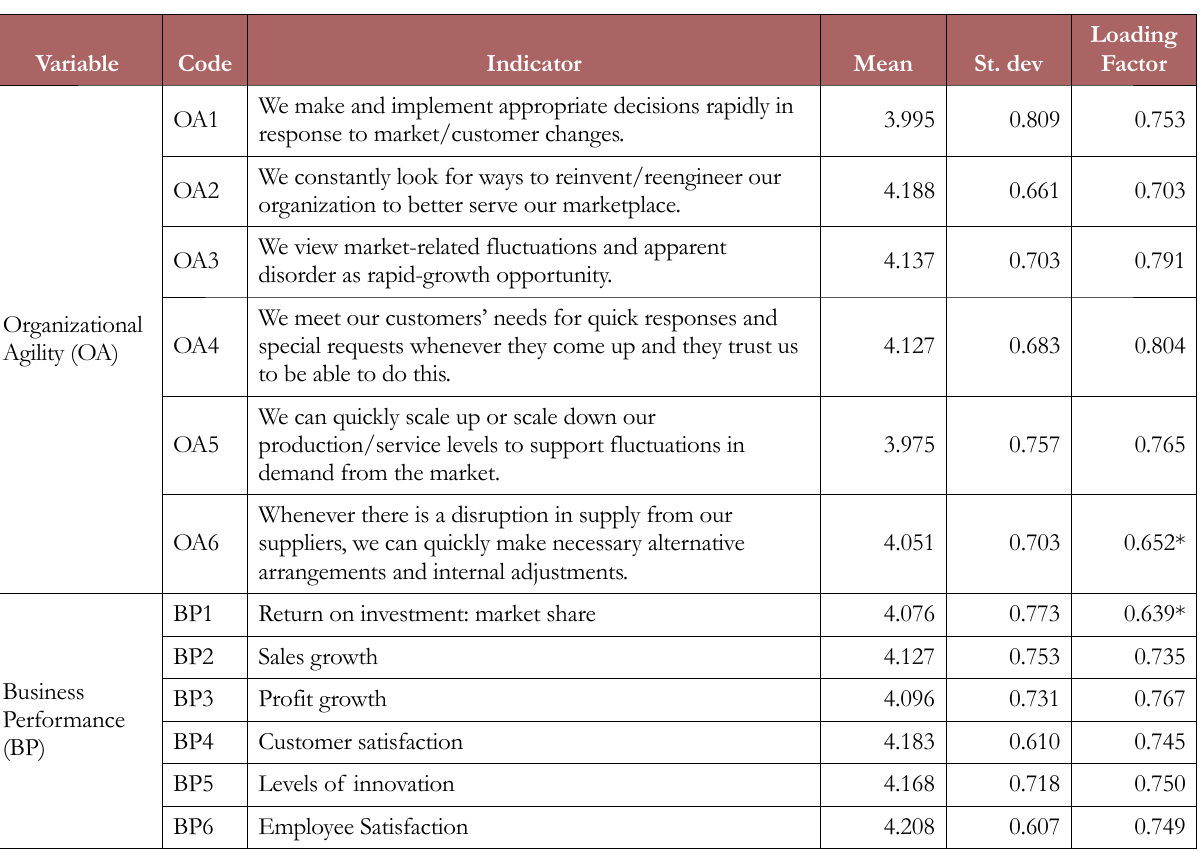
Table 2. Loading factors of the indicators